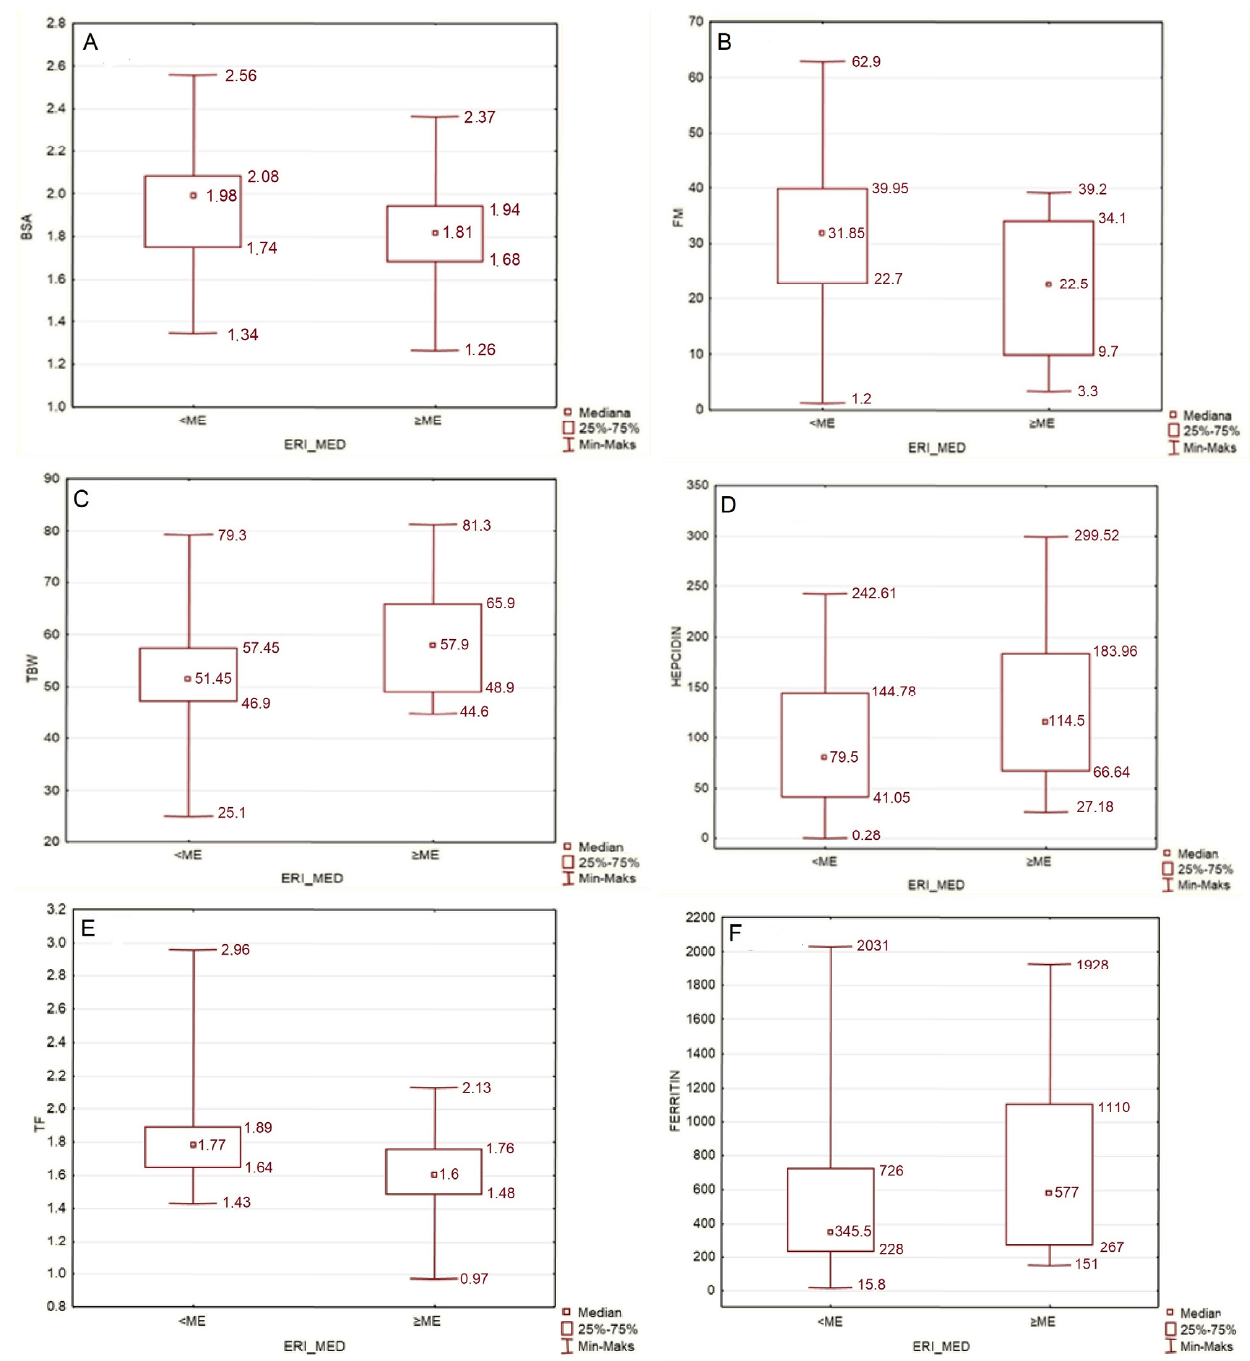
Figure 3. ( A ) Comparison of BSA in groups with ERI lower and higher than median ( p = 0.033). ( B ) Comparison of FM in groups with ERI lower and higher than median ( p = 0.024). ( C ) Comparison of TBW [%] in groups with ERI lower and higher than median ( p = 0.024). ( D – F ) Comparison of hepcidin [ng/mL], transferrin [g/L] and ferritin serum level [ µ g/L] in groups with ERI lower and higher than median ( p = 0.043; p = 0.002; p = 0.041, respectively). There was a significant, even after Bonferroni correction, inverse correlation between eGFR and ERI ( ρ = − 0,40; p = 0.0004, plot not shown). We compared Kt/V values between groups of different body composition and BMI (Table 4), and the results were as